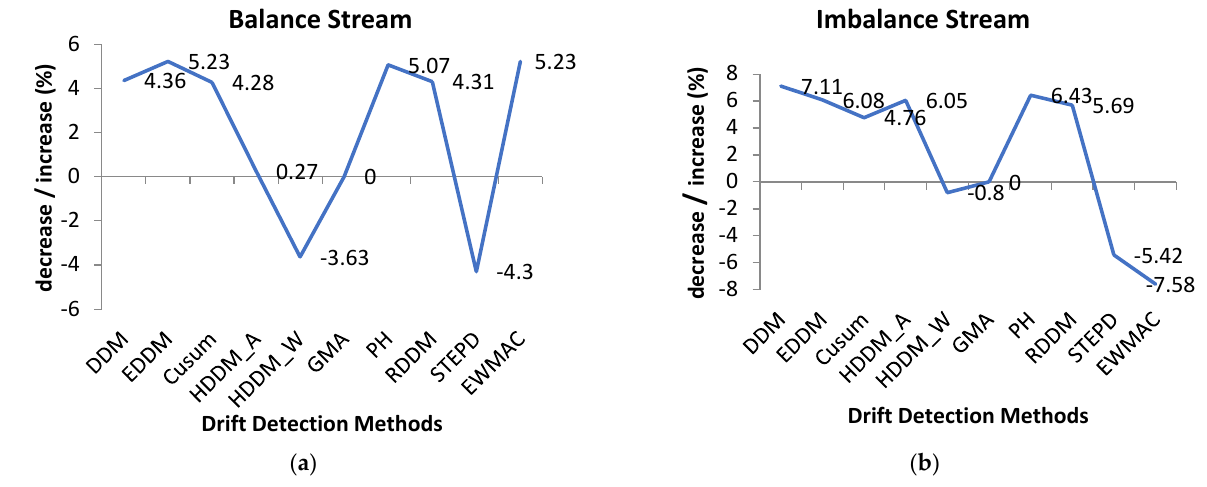
Figure 7. Effect of drift detection methods on base classifier’s performance in case of gradual drift. ( a ) Gradual drift without class imbalance; ( b ) Gradual drift with class imbalance. Again, we looked into the false alarm factor, as we did for streams with sudden drift.